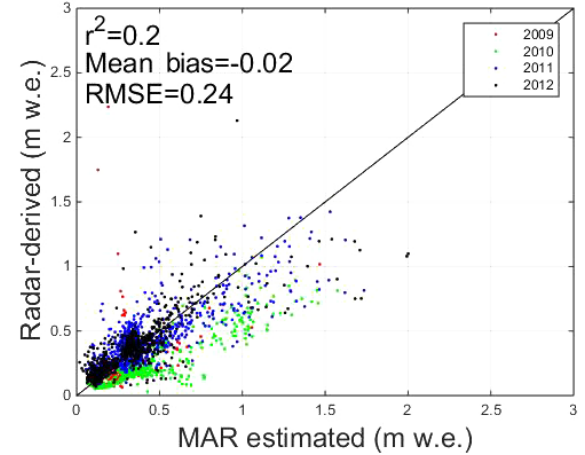
Figure 11. Comparison between radar-derived and MAR-estimated accumulation rate (mw.e.a − 1 ) . Radar-derived accumulations (Fig. 4) were averaged within each MAR grid cell. Figure 10 shows the spatial distribution of the